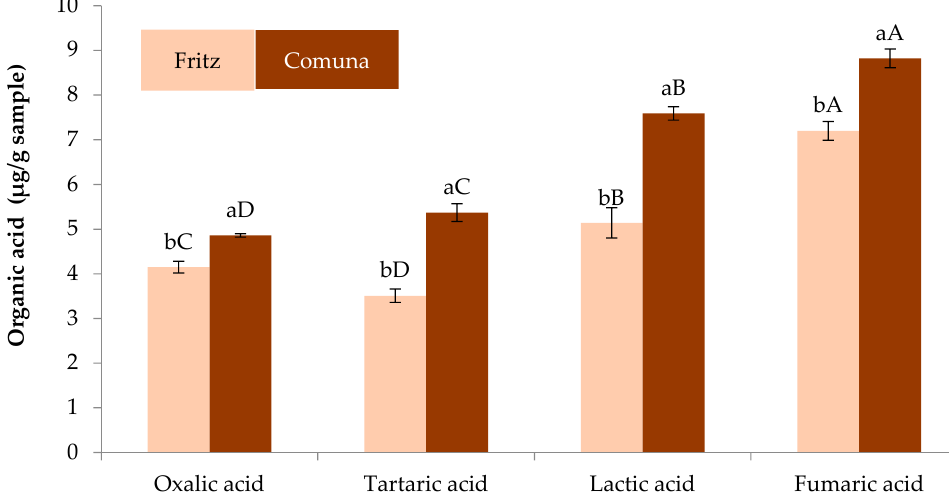
Figure 1. Organic acids content of almond skin flours obtained from Turrón coproducts. For the same compound, bars followed by different lowercase letter are significantly different ( p < 0.05) according to Tukey’s Multiple Range Test. For the same almond skin bars followed by different capital letter are significantly different ( p < 0.05) according to Tukey’s Multiple Range Test.